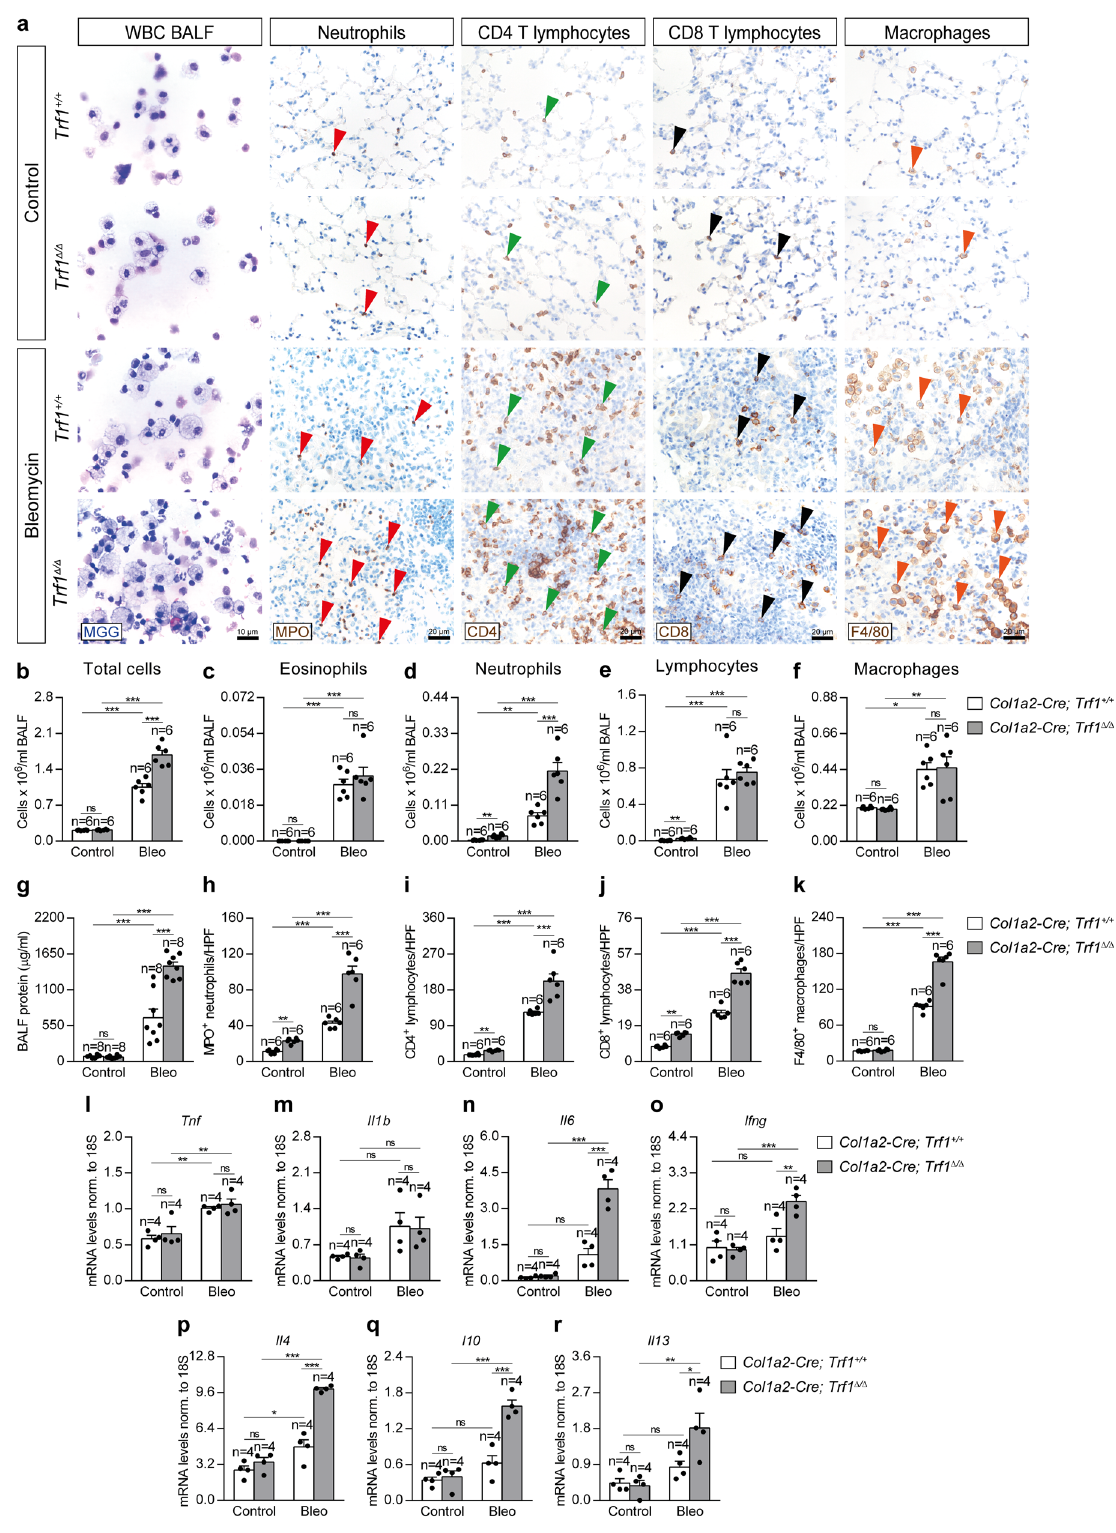
Fig. 4 | Trf1 deletion in lung fi broblasts exacerbates bleomycin-induced in fl ammatory response. a Representative BALF cytospin preparations (May-Grün- wald Giemsa (MGG)) and immunostainings for MPO (red arrowheads indicate MPO + neutrophils), CD4 and CD8 (green and black arrowheads indicate CD4 + and CD8 + T lymphocytes) and F4/80 (orange arrowheads indicate F4/80 + macrophages) in lung sections from control and BLM-challenged Trf1 +/+ and Trf1 Δ / Δ mice. Quanti fi cation of total ( b ) and differential BALF cell counts for eosinophils ( c ), neutrophils ( d ) lym- phocytes ( e ) and macrophages ( f ) and total protein concentration in BALF ( g ), of